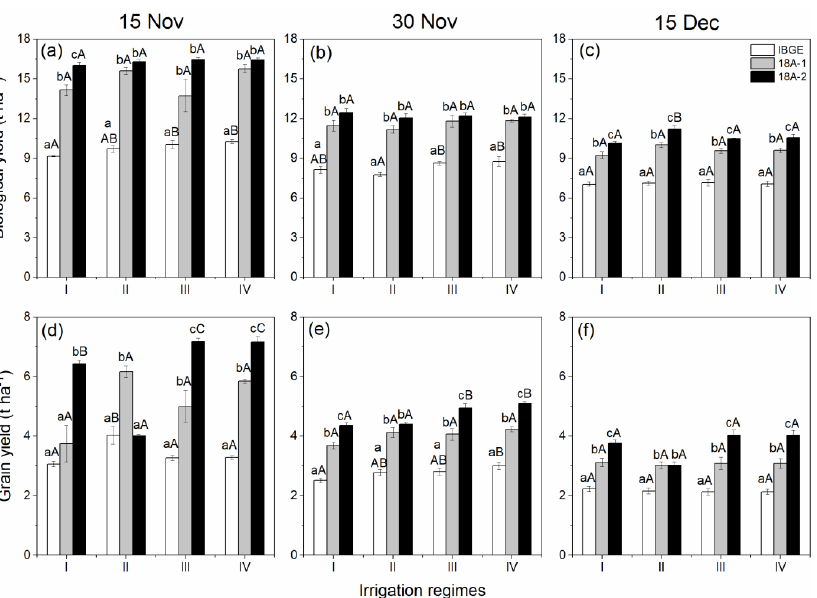
Figure 5. Effects of irrigation regimes on biological and grain yields of wheat cultivars sown on different dates. Bars show mean values of six replicates from two growth cycles and contain standard errors of means ( n = 6). In each panel, bars under each irrigation regime with different lowercase letters show significant differences between wheat cultivars, and bars of each cultivar with different uppercase letters show significant differences between irrigation regimes at p < 0.05. I — irrigation at tillering stage; II — irrigations at tillering and booting stages; III — irrigations at tillering, booting, and flowering stages; IV — irrigations at tillering, booting, flowering, and grain filling stages. Nov = No- vember, Dec = December.